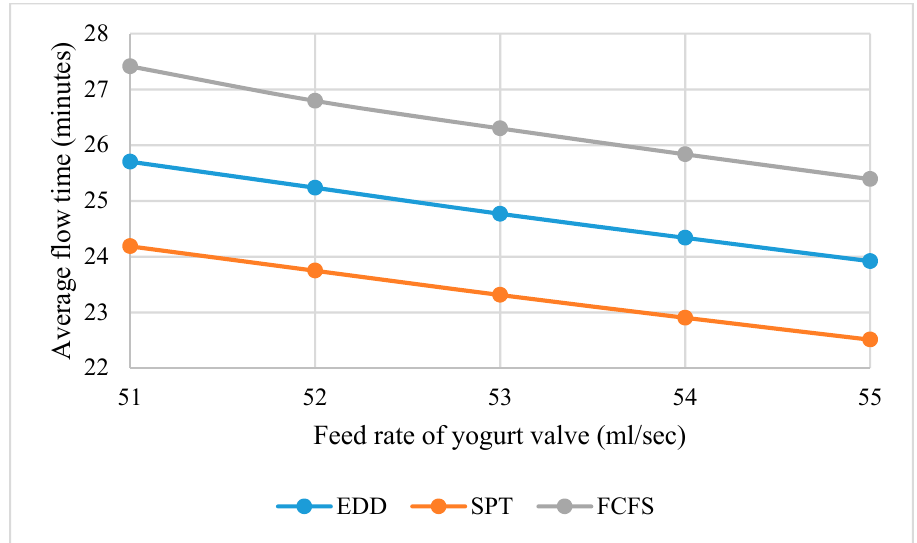
Figure 9. The effect of feed rate of yogurt valve on average flow time. The second performance measure (average minutes early) was investigated, and it increases with the increase in the feed rate of the yogurt valve, as shown in Figure 10. The average minutes early, in the case of FCFS, is higher than SPT and EDD. Initially, there is a sudden increase in the average minutes early, but then it is uniformly changing with the change in yogurt feed rate. Moreover, the change in average minutes early per unit change in yogurt feed rate is greater in the case of FCFS than EDD and SPT.